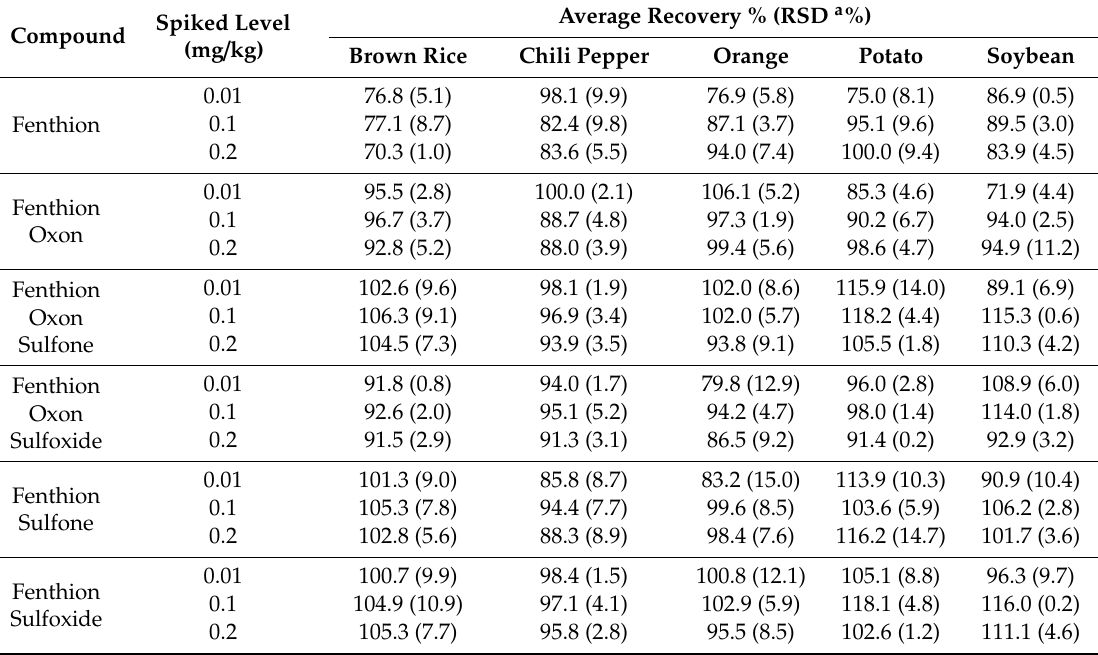
Table 2. Average recovery rates and relative standard deviations in five matrices ( n =